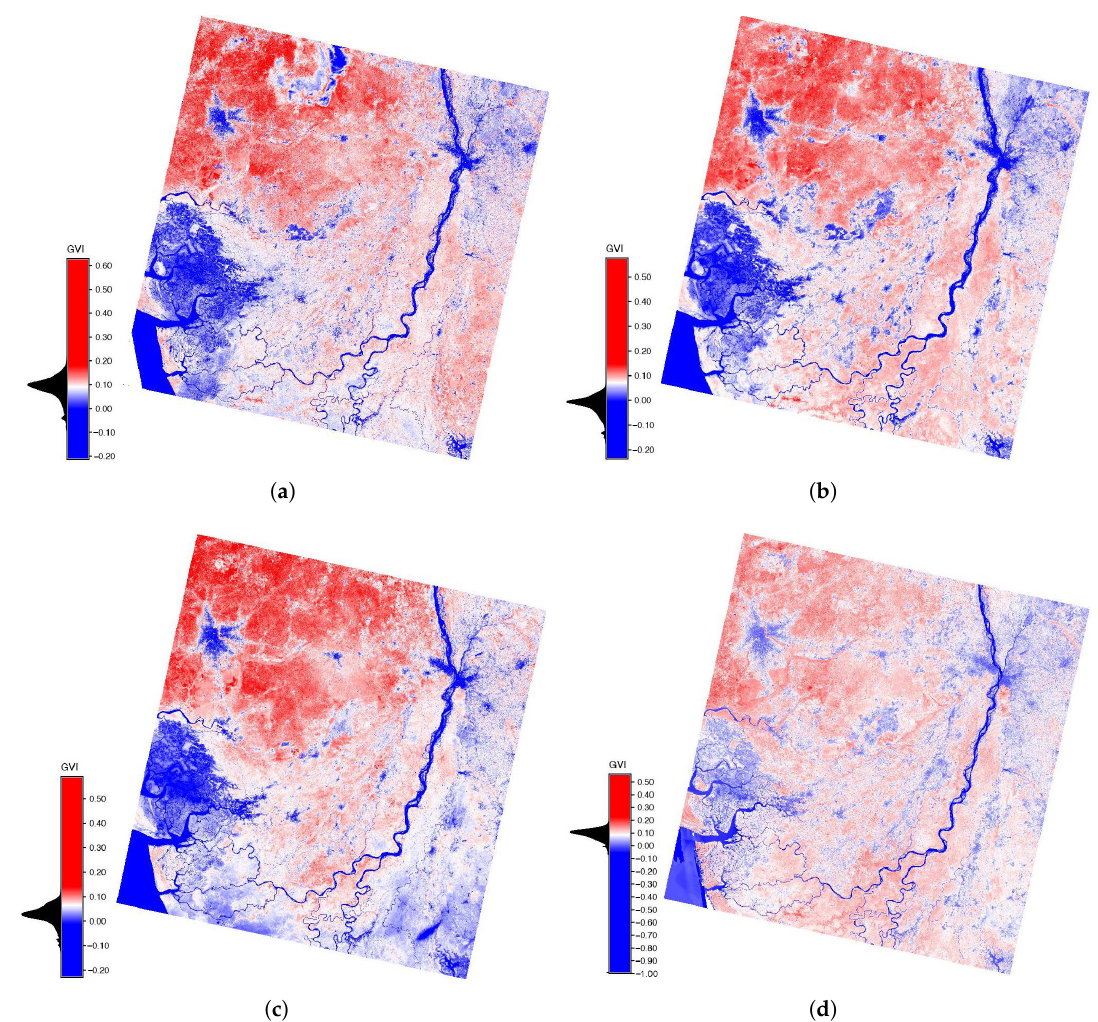
Figure 6. GVI computed from the Landsat 8-9 OLI/TIRS images of Niger River Delta for four years: ( a ) 2013, ( b ) 2015 ( c ) 2021, ( d )